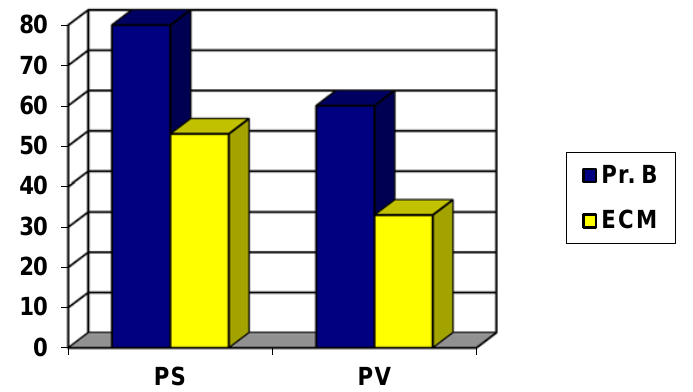
Figure 3. Percentage of target-like performance.